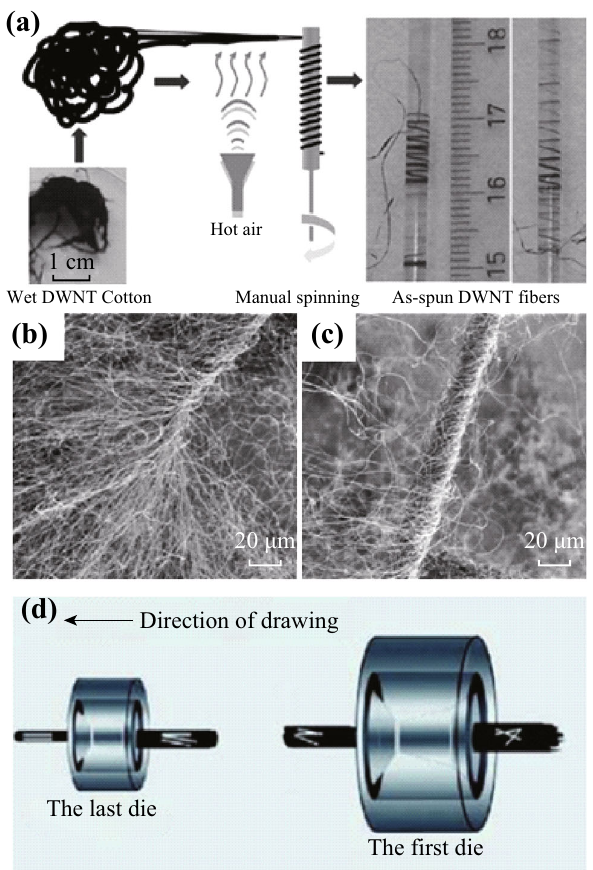
Fig. 8 a Schematic illustration of the drawing–drying spinning process and optical images of the as-spun DWNT fibers. b , c SEM images of CNT cotton based fibers. d Schematic of fiber shaping by drawing CNT films through a series of diamond wire drawing dies. a Reproduced with permission from Ref. [41]. Copyright 2007, Wiley–VCH. b , c Reproduced with permission from Ref. [42]. Copyright 2007, Wiley–VCH. d Reproduced with permission